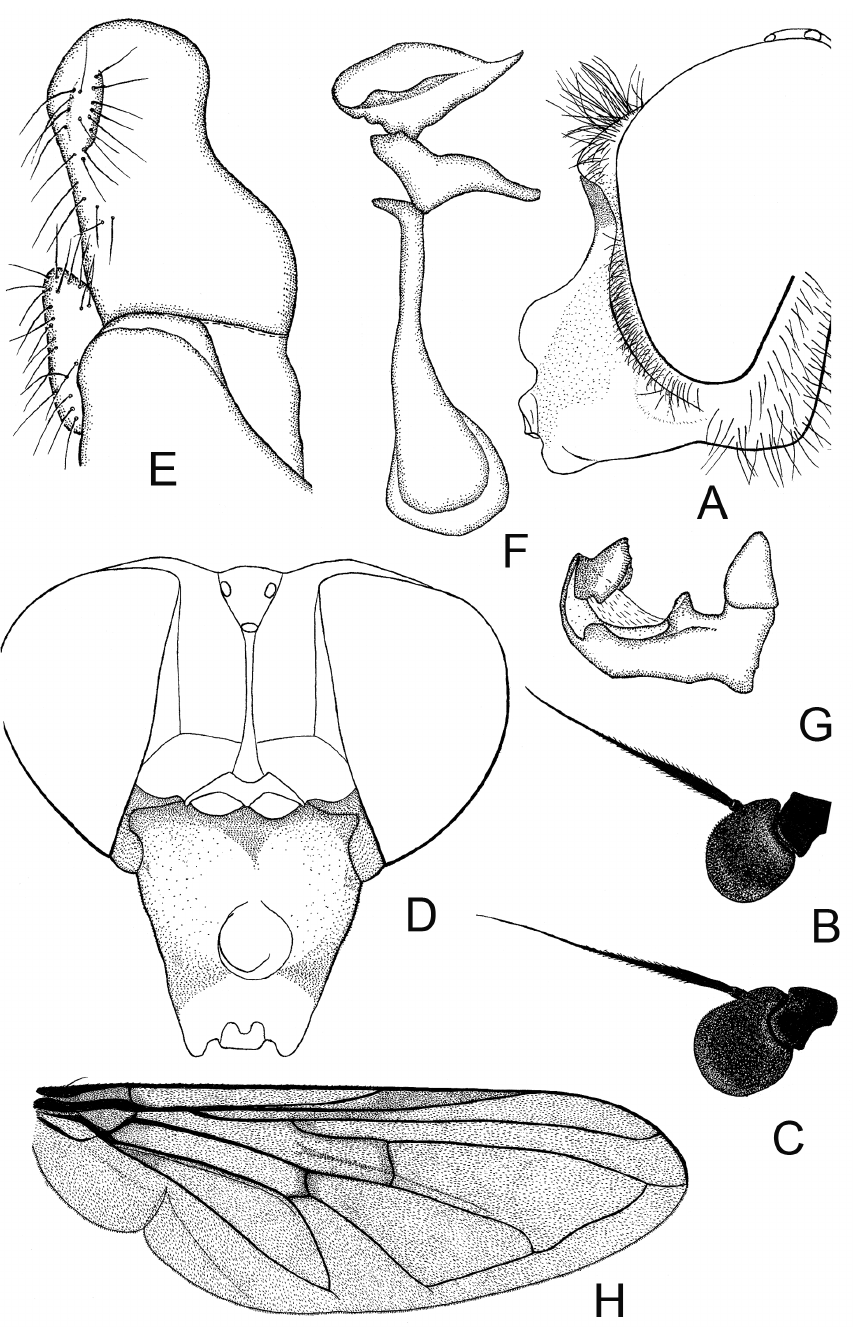
Figure 10. Cheilosia laeviventris Loew. A Male head, lateral view; B antenna of male, lateral view C Anten- na of female, lateral view D Female head, dorsal view E–G male genitalia, lateral, from left to right: E Cercus +surstylus F Aedeagal complex G Superior lobe H Male,